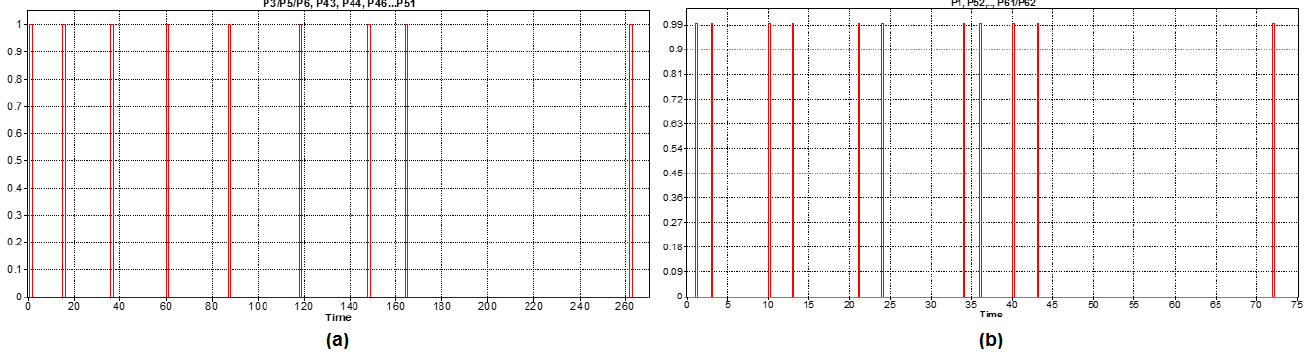
Figure 15. Monitoring signals in PN Sirphyco simulation: ( a ) disassembly WP2, ( b ) repair WP2.